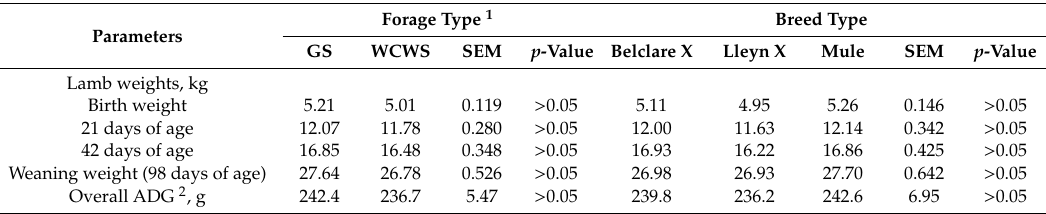
Table 7. The e ff ect of forage type and breed type on lamb body weight (BW) and average daily gain (ADG; least square means ±